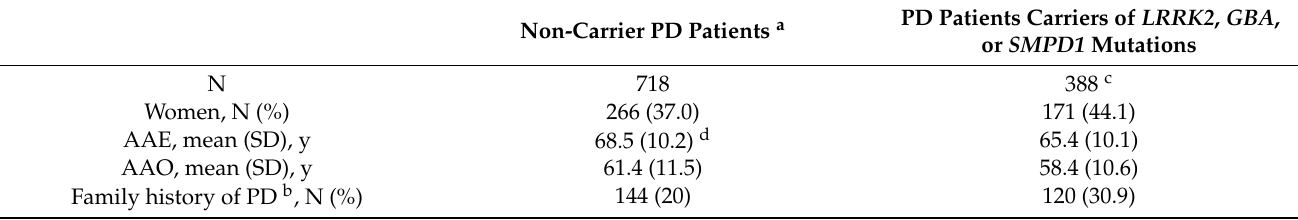
Table 1. Characteristics of the 1106 Parkinson’s disease patients of Ashkenazi Jewish origin. PD Patients Carriers of LRRK2 , GBA Non-Carrier PD Patients a